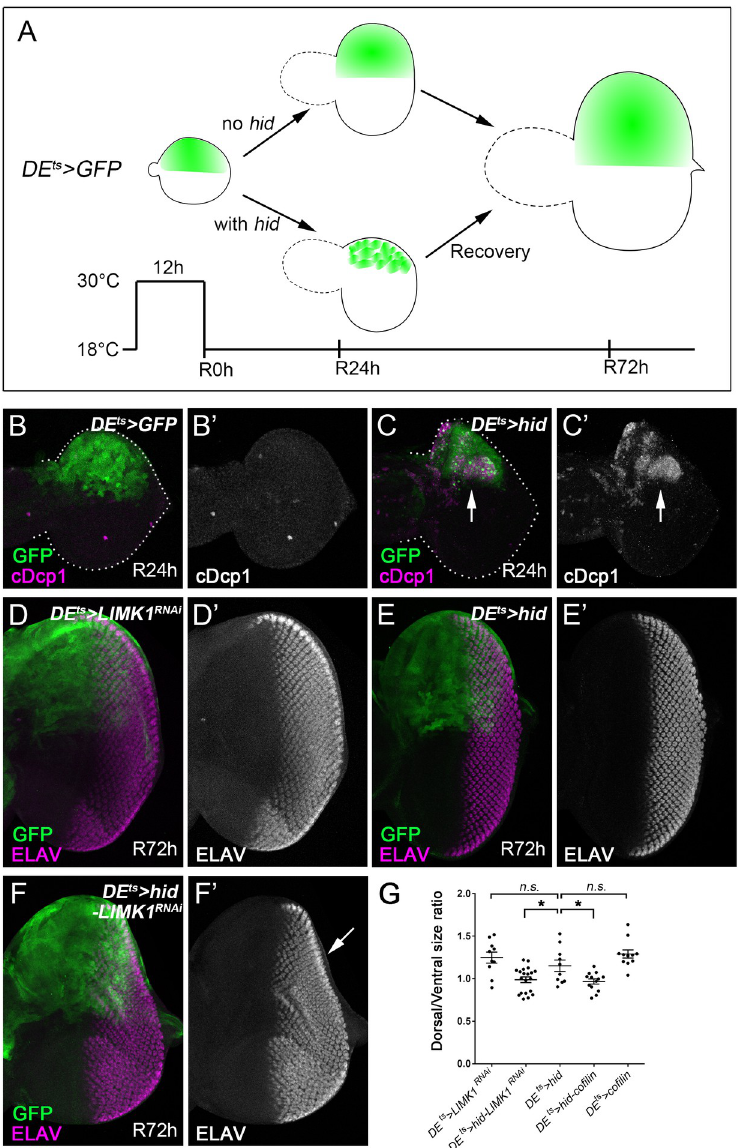
Fig 2. LIMK1 is required for complete tissue regeneration in response to apoptosis. (A) A schematic representation of the AiP-dependent regeneration assay. Conditional expression of GFP and the pro-apoptotic gene hid is under control of the Dorsal Eye-GAL4 ( DE-GAL4 ) driver, which is expressed in the dorsal half of the eye disc, together with tub-GAL80 ts , a ubiquitously expressed and temperature sensitive (ts) inhibitor of GAL4. tub-GAL80 ts inhibits DE-GAL4 ( DE ts ) at 18˚C, but not at 30˚C. In this regeneration assay, a temperature shift to 30˚C for 12 hours during second instar larval stage induces expression of GFP together with or without hid . This is then followed by a recovery period at 18˚C. Compared to the control with GFP expression only, a 12-hour expression of hid results in tissue ablation in the dorsal eye half, which is regenerated completely after a recovery period of 72 hours (R72h). (B-C’) Early 3 rd instar eye discs, anterior is to the left, were labelled with GFP (green in B, C) and an apoptosis marker cDcp1 (magenta in B, C and grey in B’, C’). Dashed lines highlight the discs. Compared to the control ( DE ts > GFP , B, B’), conditional expression of hid ( DE ts > hid , C, C’) for 12 hours under the control of DE ts results in a strong induction of apoptosis (arrows) and loss of bilateral symmetry of the disc which are visible after a recovery period of 24 hours (R24h). (D-F’) Late 3 rd instar eye discs, anterior is to the left. ELAV (magenta in D, E, F and grey in D’, E’, F’) labels photoreceptor neurons and is used to outline the shape of the discs. Conditional expression of LIMK1 RNAi (D, D’), hid (E, E’) or hid and LIMK1 RNAi (F, F’) was under control of DE ts and indicated by GFP (green in D, E, F). A temperature shift to 30˚C for 12 hours was followed by a recovery period of 72 hours at 18˚C (R72h). (D, D’) Following this protocol, expression of LIMK1 RNAi alone ( DE ts > LIMK1 RNAi ) does not affect the eye disc morphology indicated by